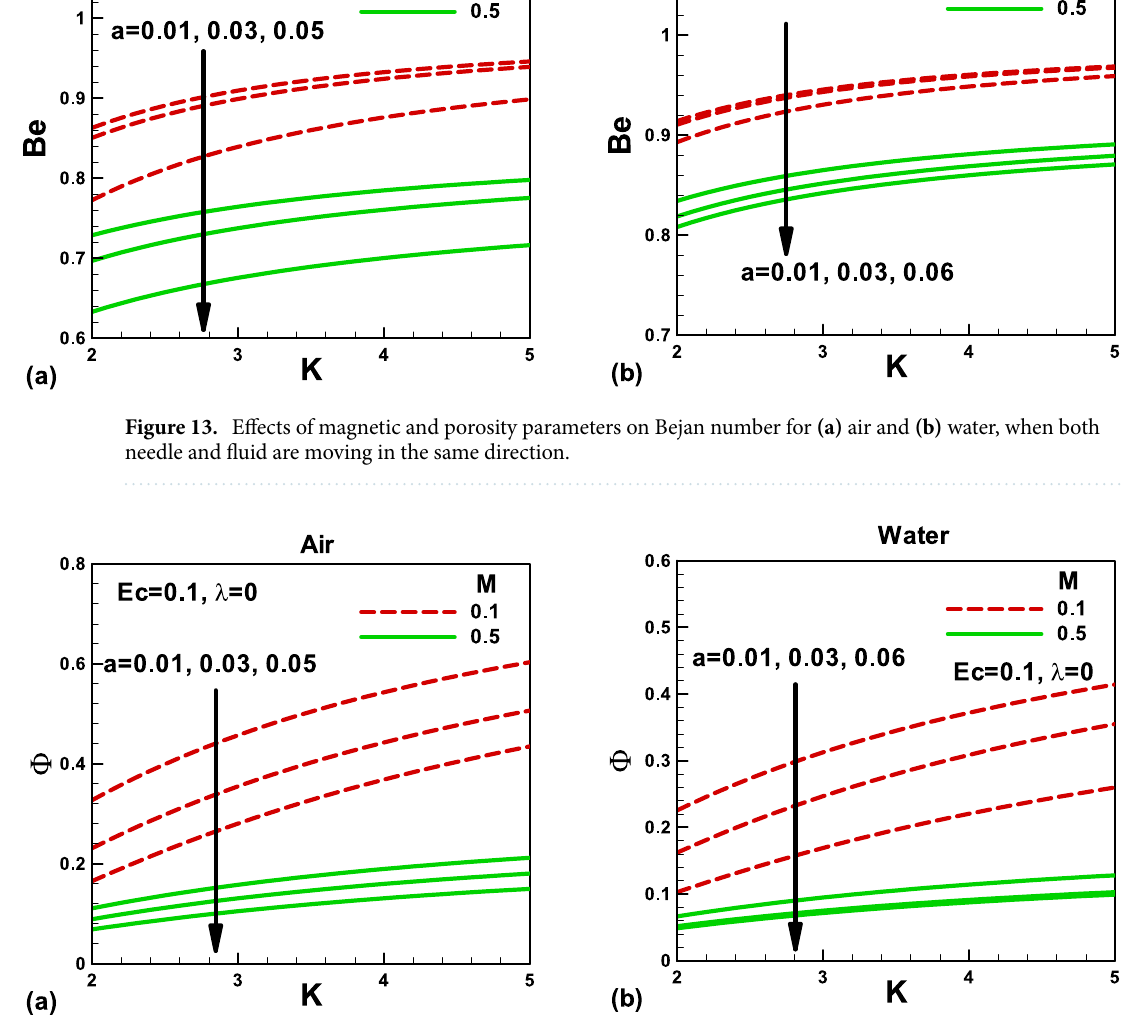
Figure 14. Effects of magnetic and porosity parameters on irreversibility distribution ratio for (a) air and (b) water, when the needle is fixed in a moving